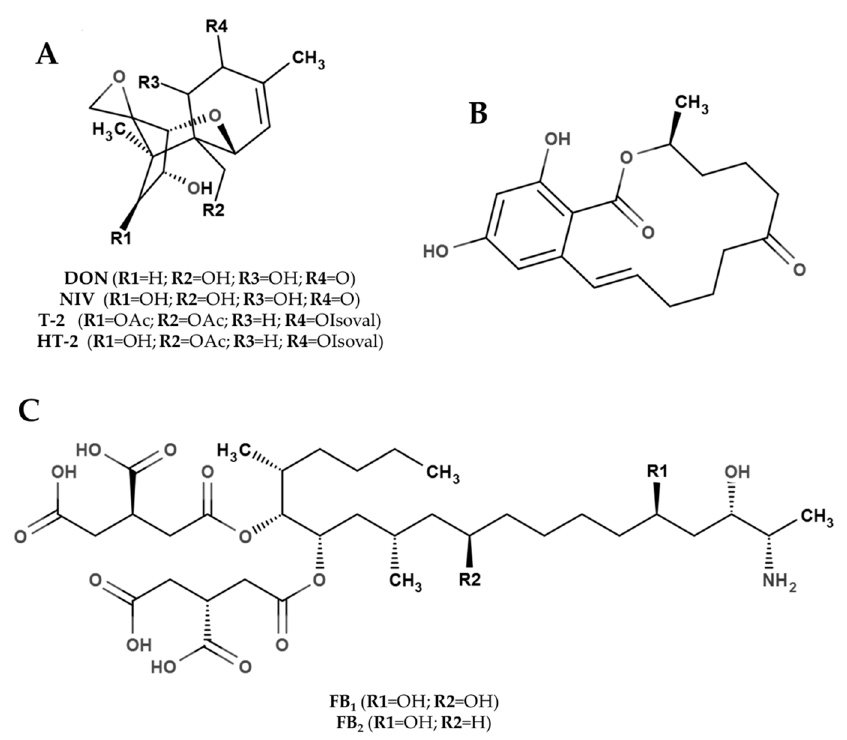
Figure 1. Chemical structure of the main Fusarium mycotoxins. ( A ) Trichothecenes; ( B ) Zearalenone; ( C ) Fumonisins; OAc = acetyl function; OIsoval = isovalerate function.